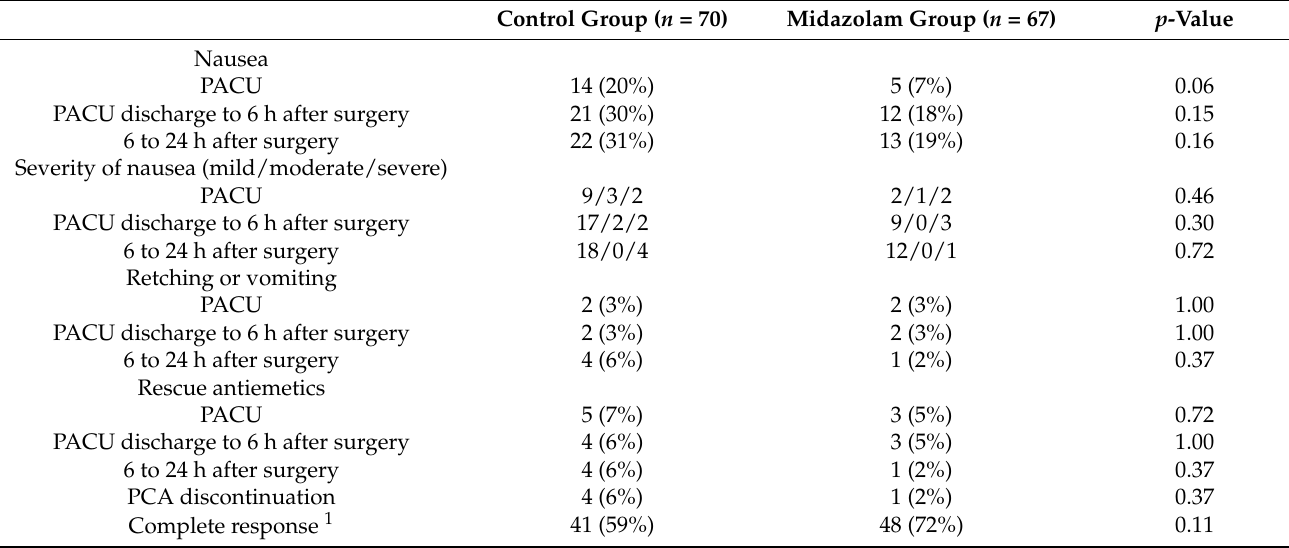
Table 2. Postoperative nausea and